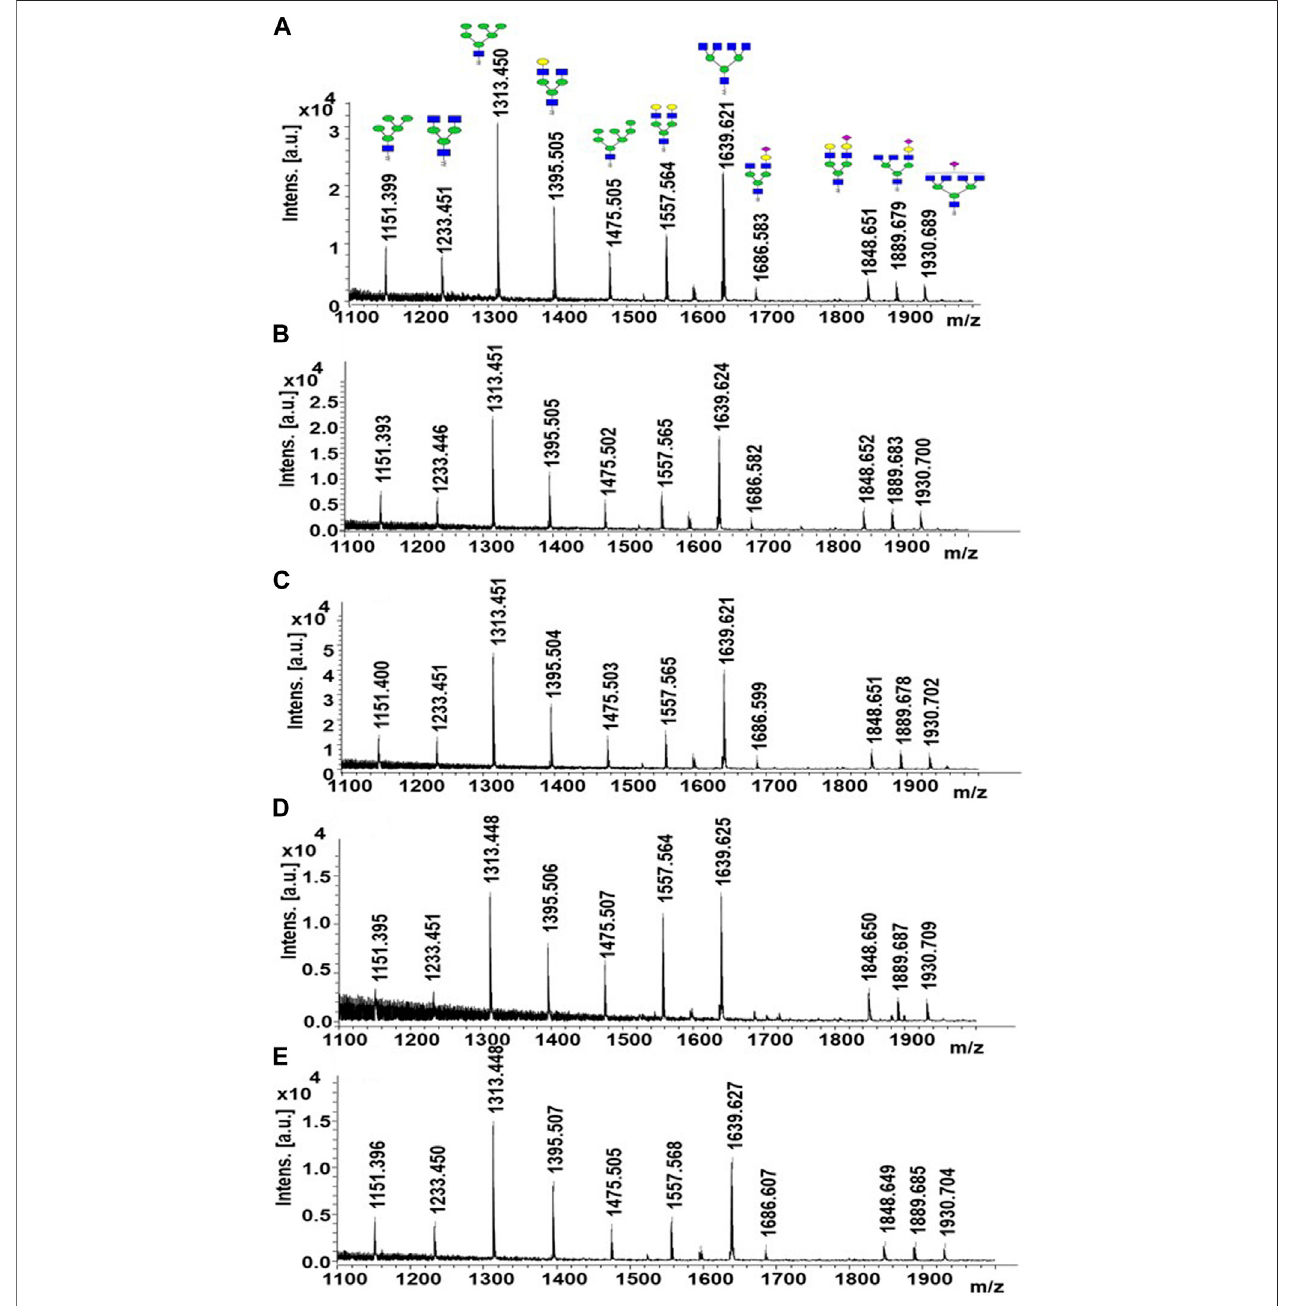
FIGURE 5 | MALDI-MS spectra of released N -glycans obtained from free (A) , adsorption- (B) , entrapment- (C) , AminoLink- (D) , and SulfoLink-based (E) immobilized EndoBI-1.